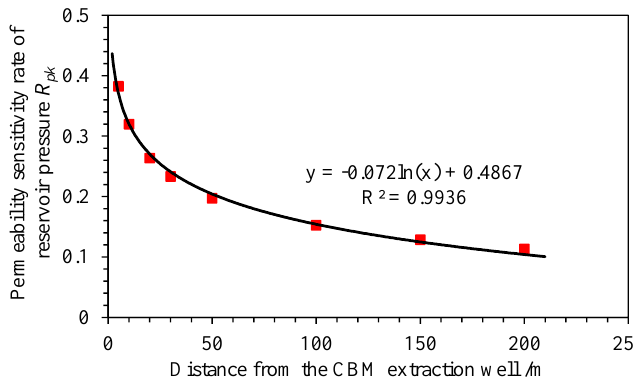
Figure 10. R pk at different distances from the CBM well.